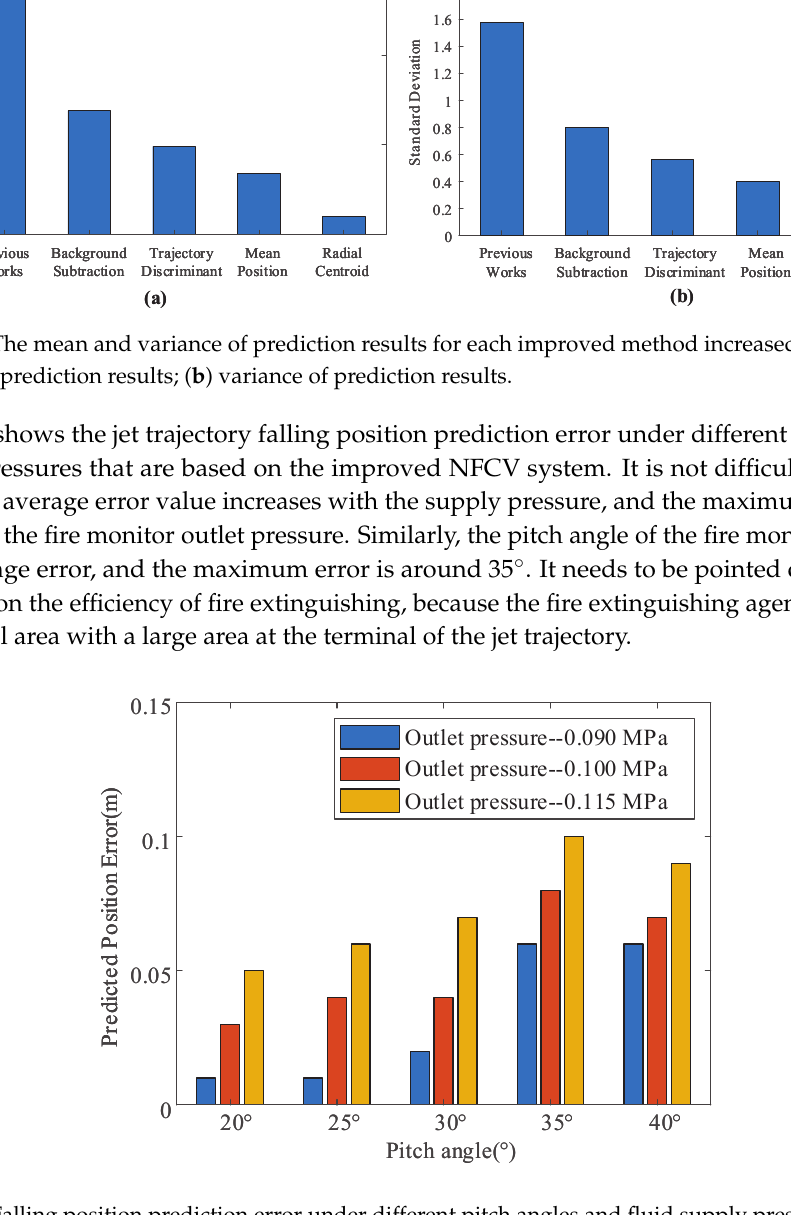
Figure 12. Falling position prediction error under different pitch angles and fluid supply pressures that are based on the improved NFCV